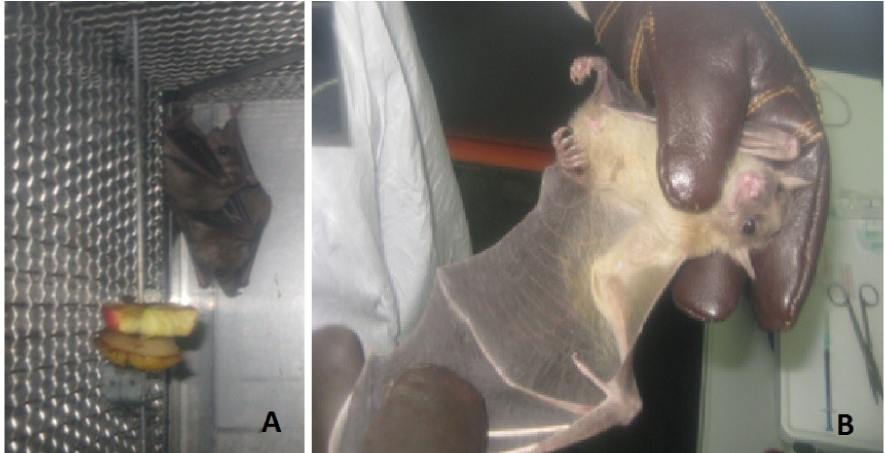
Figure 1. Handling of the bats during the immunization experiment. ( A ) Two bats kept together in one cage; ( B ) preparation of the bat for collection of blood sample. Due to the calm temperament of these animals, the sampling could be done without general